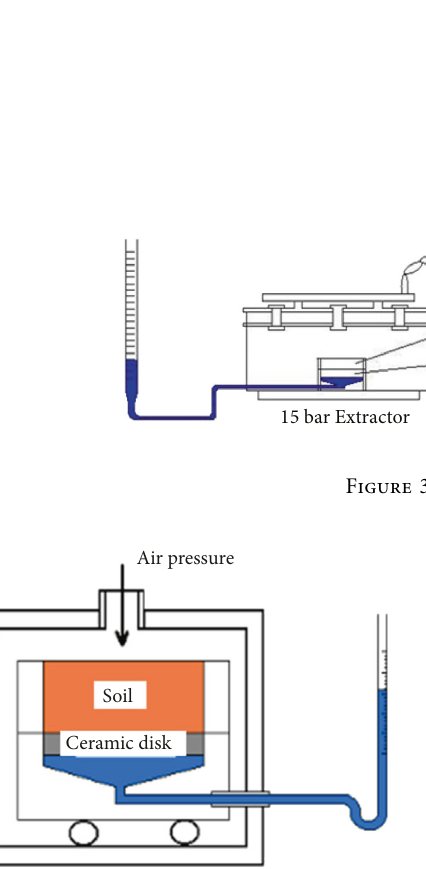
Figure 4: Modified apparatus schematic.